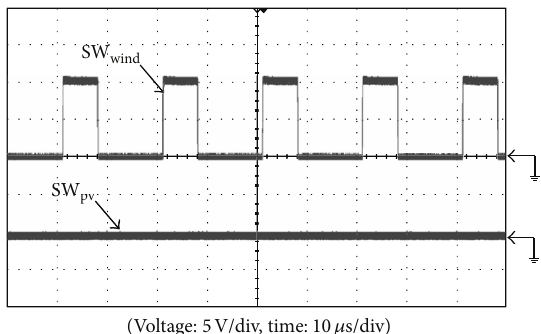
Figure 12: Practical measurements of control signals while wind turbine provides 350 W.